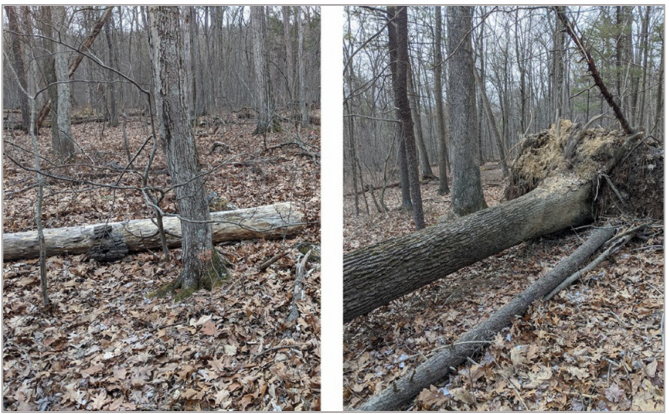
Figure 13. Examples of downed trees discovered through follow-up field visits, which were vital to gaining context and analyzing false negatives and false positives.